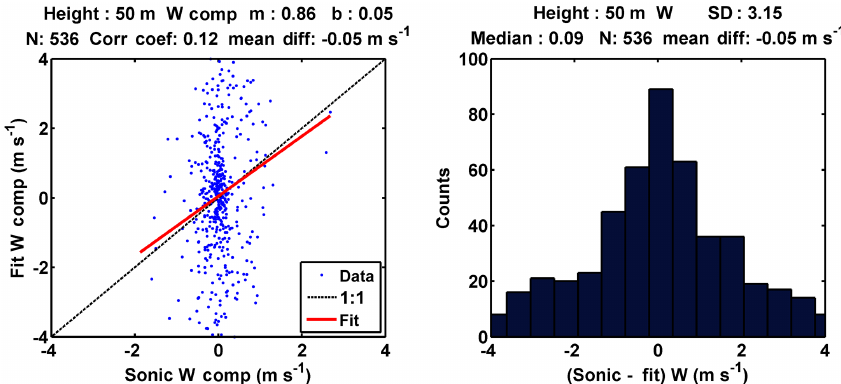
Figure 8. Comparison of the vertical velocity measurements from VTS at the 50m level with the sonic anemometer